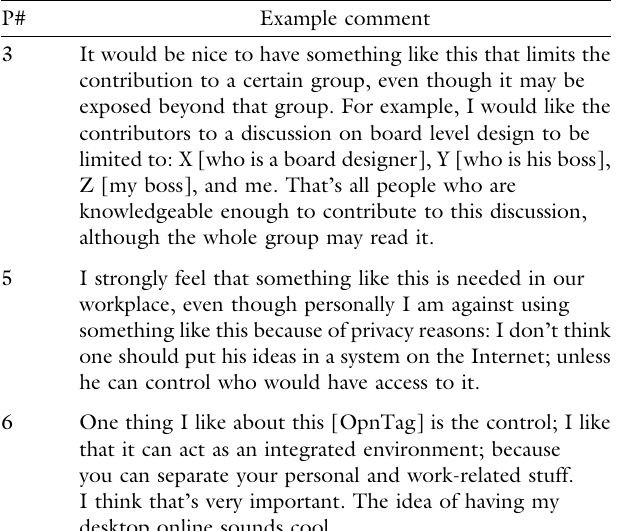
Table 8. Participants ’ comments on willingness to adopt the